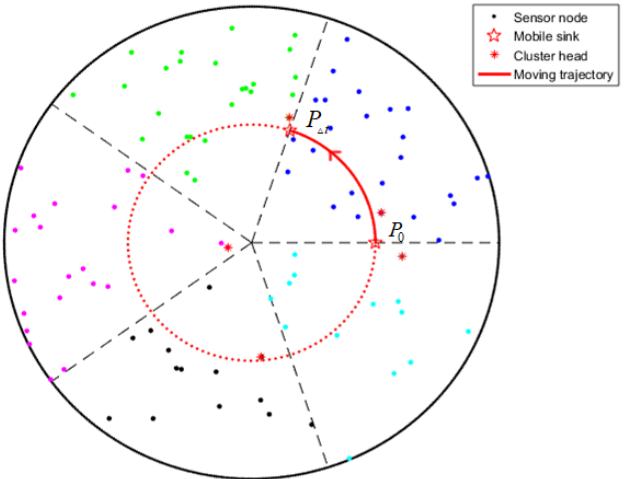
Figure 6. Trajectory of mobile sink.